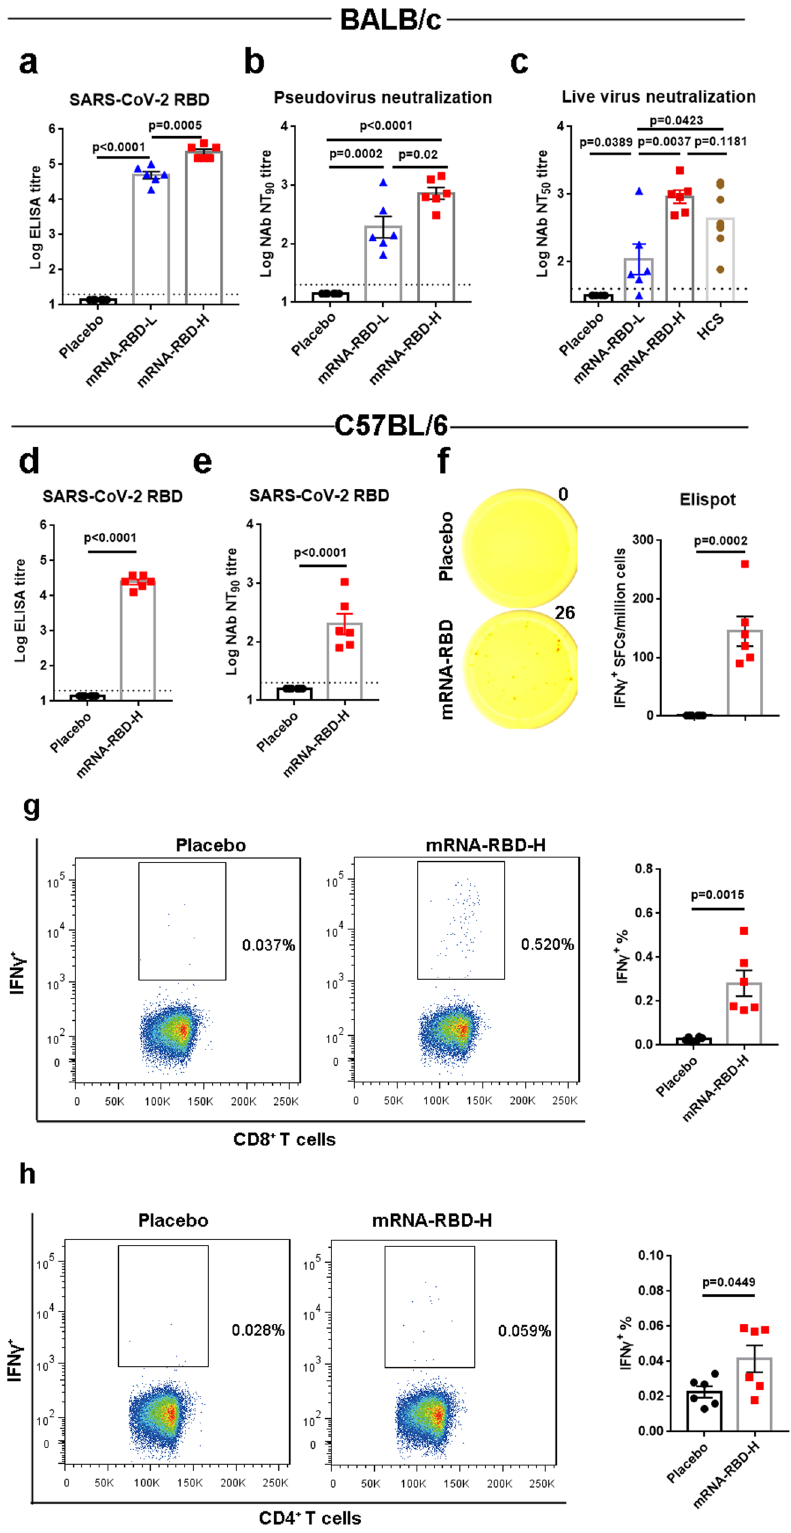
with 1 × 10 5 FFU of SARS-CoV-2 via the intranasal (i.n.) route (Fig. 3a). We recorded the body weight for each mouse daily after infection for 5 days and found that the body weights of both prime and boost group mice showed a similar decrease at 1day post infection (dpi) but a faster increase during 3 – 5 dpi compared to the placebo group (Fig. 3d). Mice were euthanized at 5 dpi,